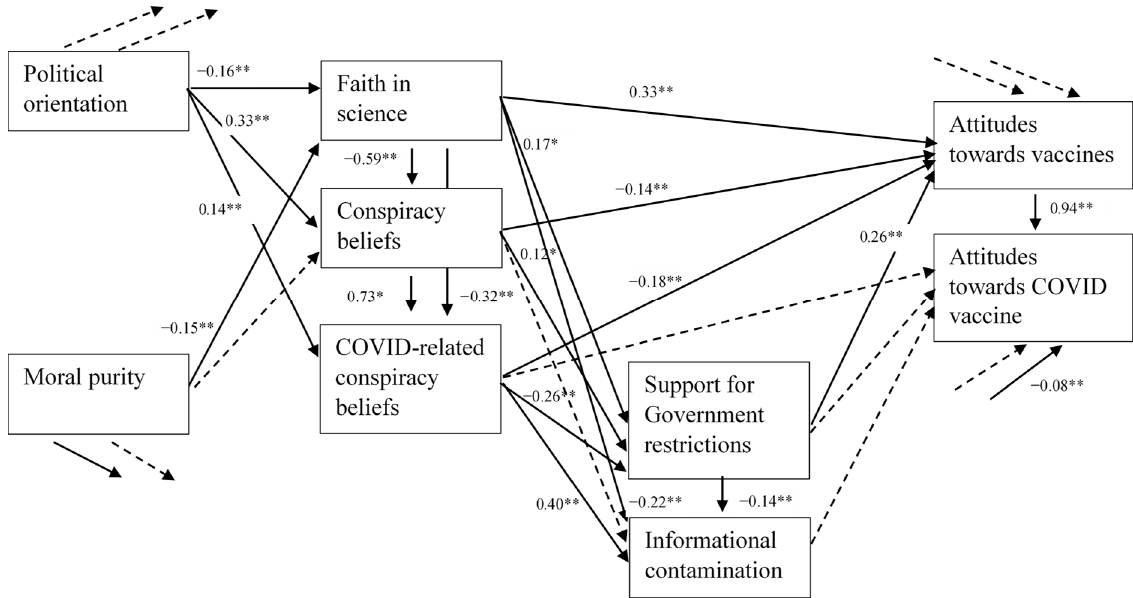
Figure 2. Model 2. Note. All variables were correlated. All of the coefficients were unstandardized. All the coefficients associated with solid lines were significant, while those associated with dashed lines were not significant beyond the p < 0.05 level. * p < 0.05; ** p < 0.001